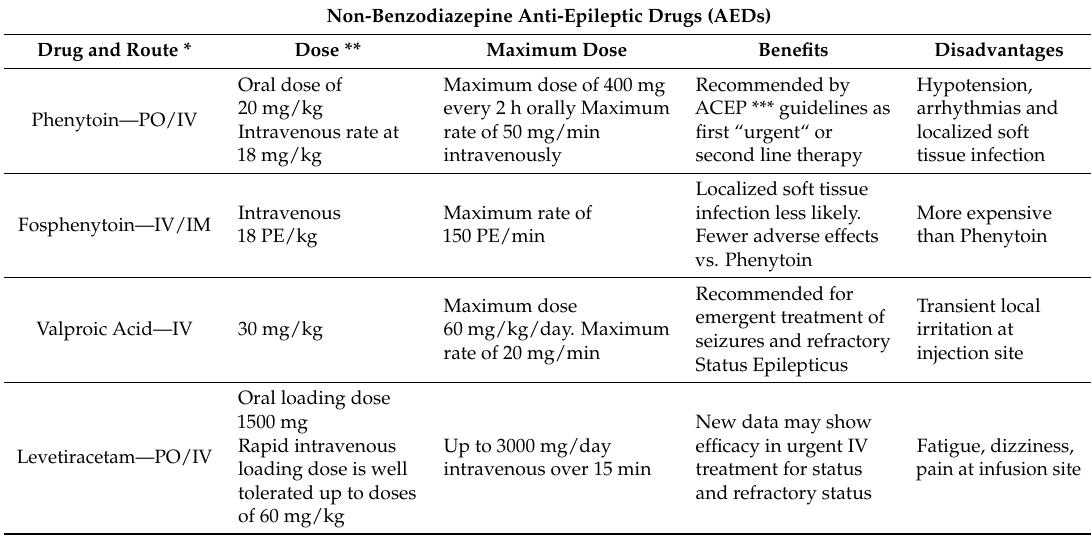
Table 3. Non-benzodiazepine anti-epileptic drugs (AEDs) and their doses [17,27]. Non-Benzodiazepine Anti-Epileptic Drugs